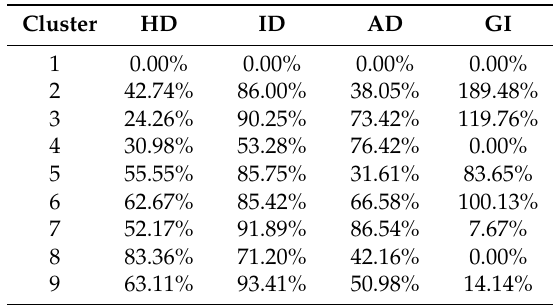
Table 4. The average extent of output improvement in nine